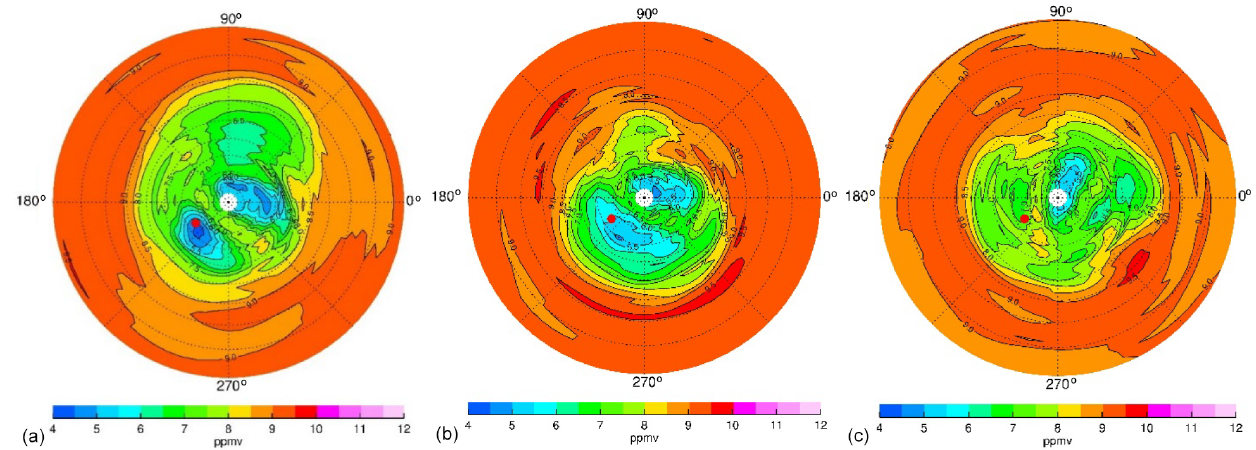
Figure 9. Maps of ozone at 4.6hPa (a) on 3 February, (b) on 10 February, and (c) on 17 February. CI is 0.5ppmv, and the red dot is Poker Flat.